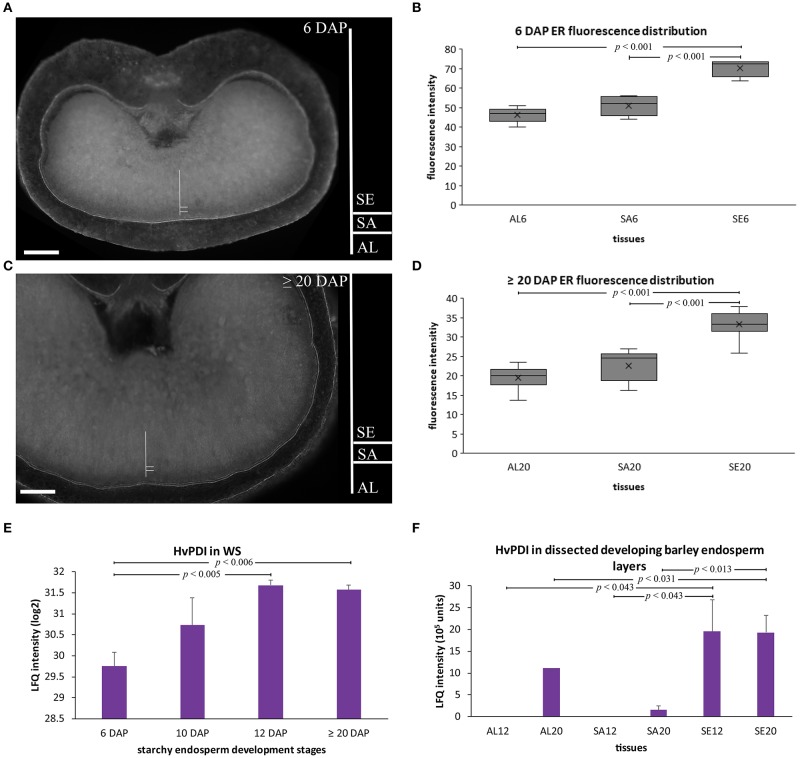
ER semi-quantitative fluorescence quantification and HvPDI relative protein abundance in developing barley endosperm. (A–D) Fluorescence quantification of the labeled ER membrane (using ER-Tracker™ Green) of sections prepared at 6 DAP (A,B) and ≥20 DAP (C,D). The quantified areas of aleurone (AL), subaleurone (SA), and starchy endosperm (SE) are indicated. scale bar = 100 μm. Descriptive boxplot statistics of the fluorescence quantity show a significant increase in the ER abundance between aleurone (AL) and starchy endosperm (SE) between 6 to ≥20 DAP, respectively (n = 5 for 6 DAP, n = 10 for ≥20 DAP). AL6 = aleurone 6 DAP, SA6 = subaleurone 6 DAP, SE6 = starchy endosperm 6 DAP, AL12 = aleurone 12 DAP, AL20 = aleurone ≥20 DAP, SA12 = subaleurone 12 DAP, SA20 = subaleurone ≥20 DAP, SE12 = starchy endosperm 12 DAP, SE20 = starchy endosperm ≥20 DAP. (E) LFQ intensities of HvPDI in the whole seed (WS) at 6, 10, 12, and ≥20 DAP. HvPDI predominantly accumulated at mid- and late development stages of developing barley endosperm. LFQ intensities of proteins were averaged over three replications. Bars represent standard deviation. For statistical analyses we performed a Student's t-test (n = 3). The p-values are indicated. Note the log2 transformation of the protein abundance dataset of the WS. (F) LFQ intensities of HvPDI in aleurone (AL) at 12, ≥20 DAP and in starchy endosperm (SE) at 12, ≥20 DAP. The prominent HvPDI abundance in the starchy endosperm (SE) at 12 and ≥20 DAP. LFQ intensities of proteins were averaged over three biological replicates. Bars represent standard deviation. The p-values are indicated.